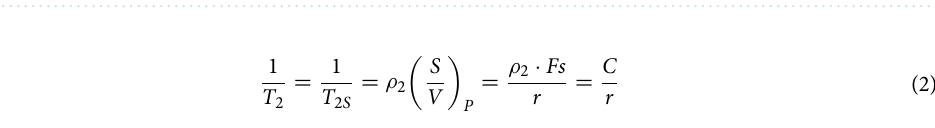
Figure 1. Capillary rise